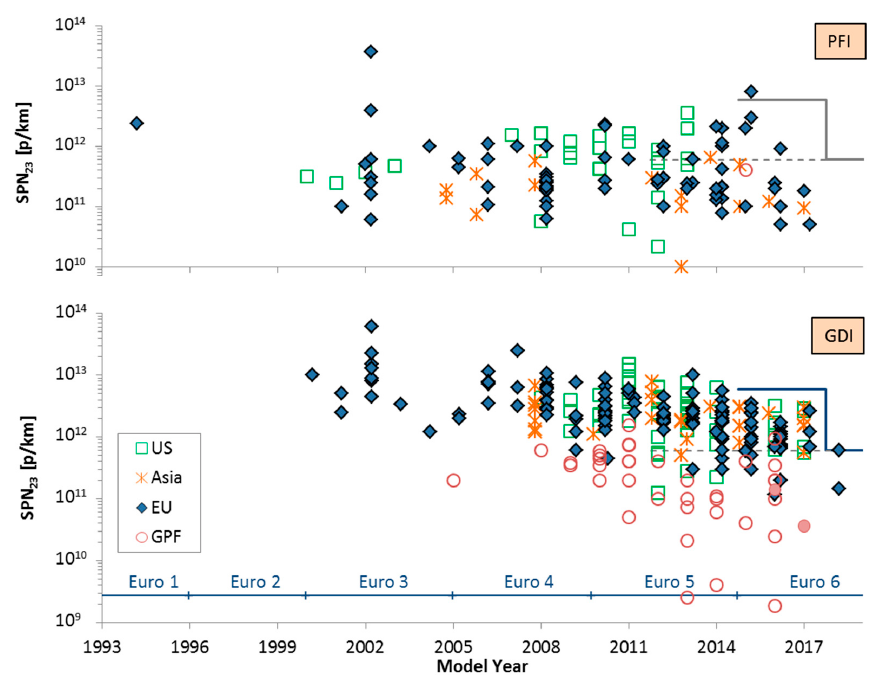
Figure 2. Solid particle number (SPN) emissions for gasoline direct injection (GDI) (lower panel) and port fuel injection (PFI) (upper panel) vehicles. Dashed line shows SPN limit for diesel vehicles (only EU). Solid line shows SPN limits for GDI vehicles (only EU). The solid circles are commercial GPF equipped vehicles (open circles are GPF retrofitted vehicles).